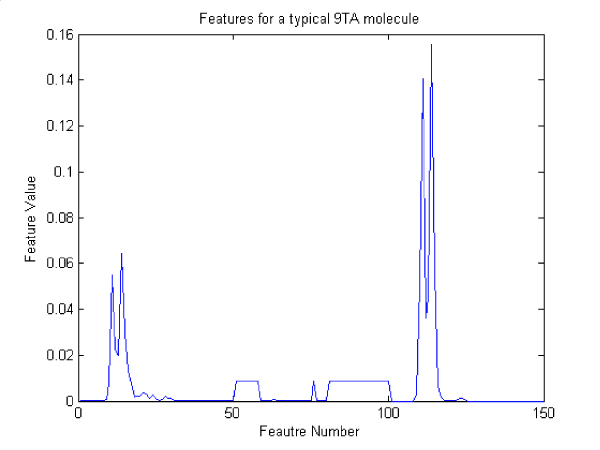
Features for a typical 9TA type molecule.